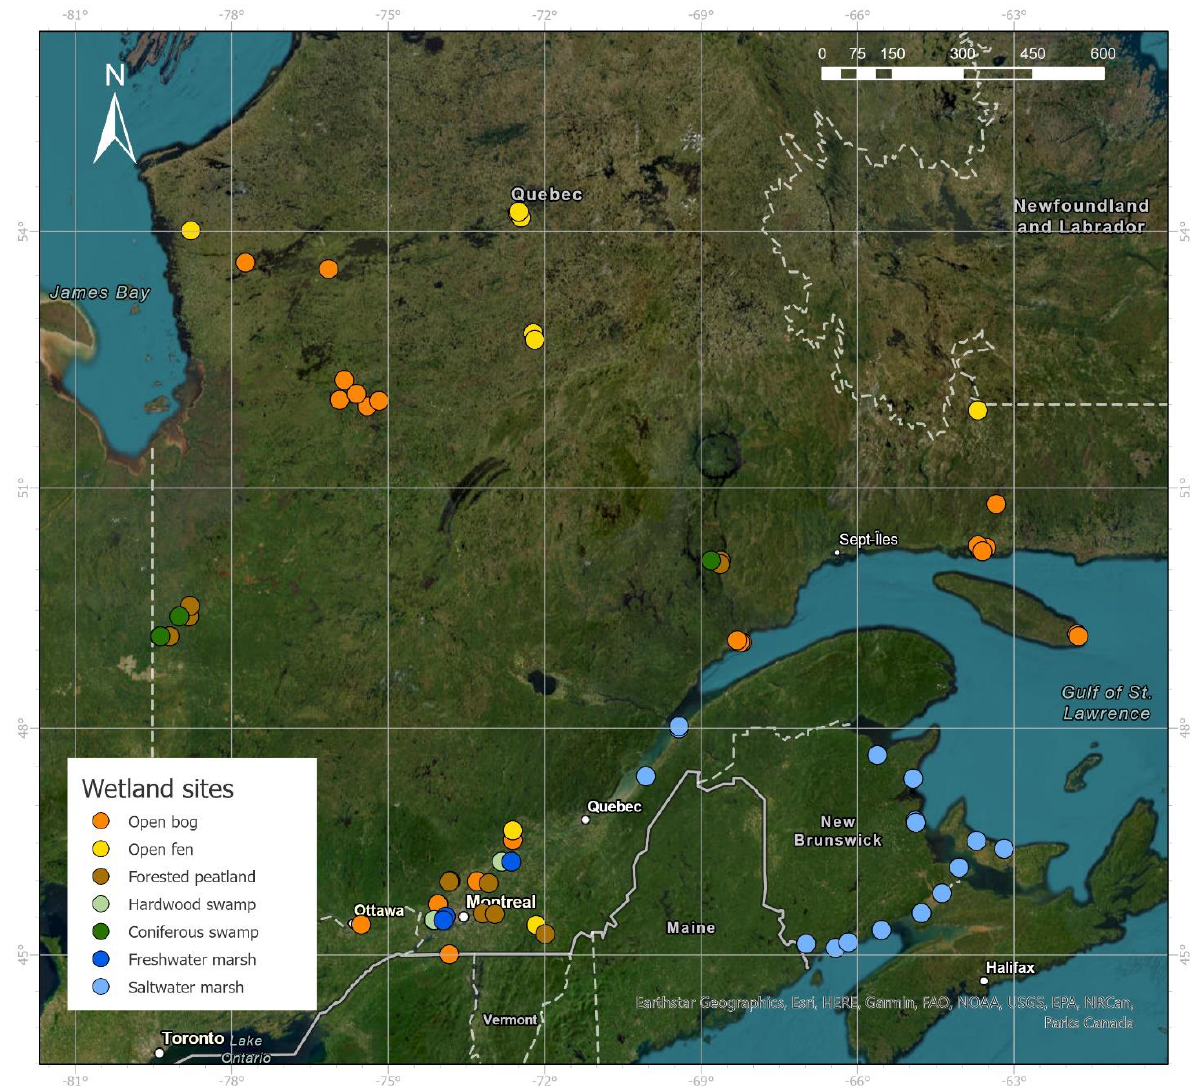
Figure 1. Location of wetlands with SOC density data from peat/soil cores included in the